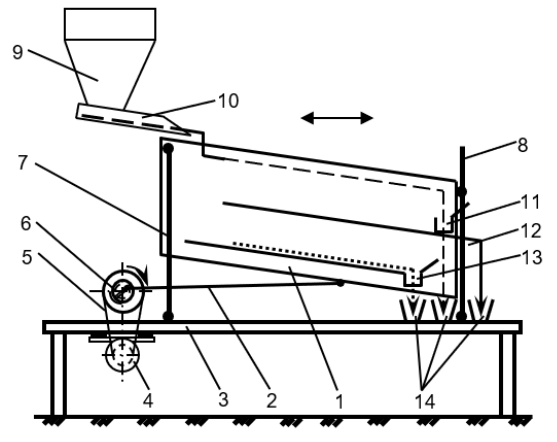
Figure 1. Structural and technological scheme of the calibration unit. 1—the unit sieves part; 2—connecting rod; 3—frame; 4—electric motor; 5—belt transmission; 6—a shaft with regulation of amplitude of oscillations; 7—front risers; 8—rear risers with a mechanism for adjusting the angle of inclination of sieves; 9—a hopper for bones; 10—distribution board; 11, 12,13—trays for removal of bones fractions; 14—receiving trays.